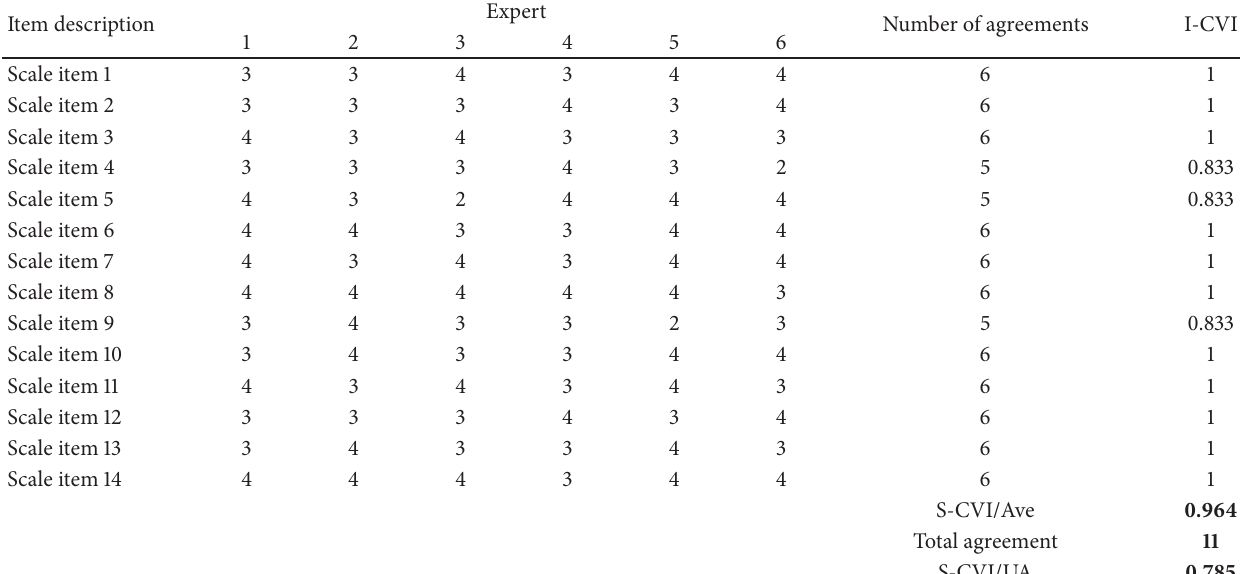
Table 4: Content validity index